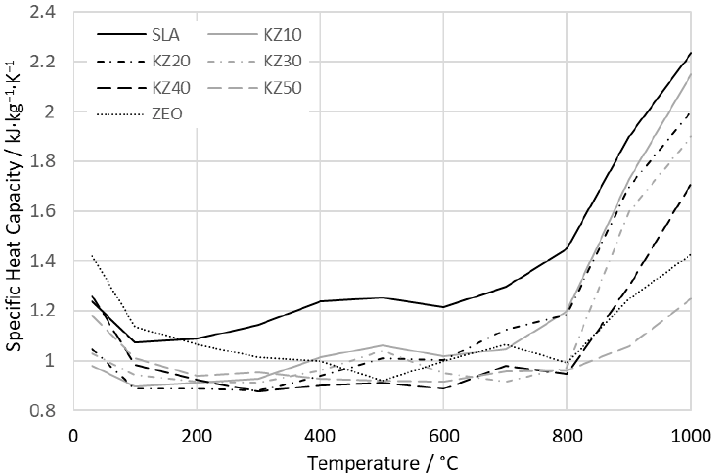
Figure 12. Specific heat capacity of the studied samples.